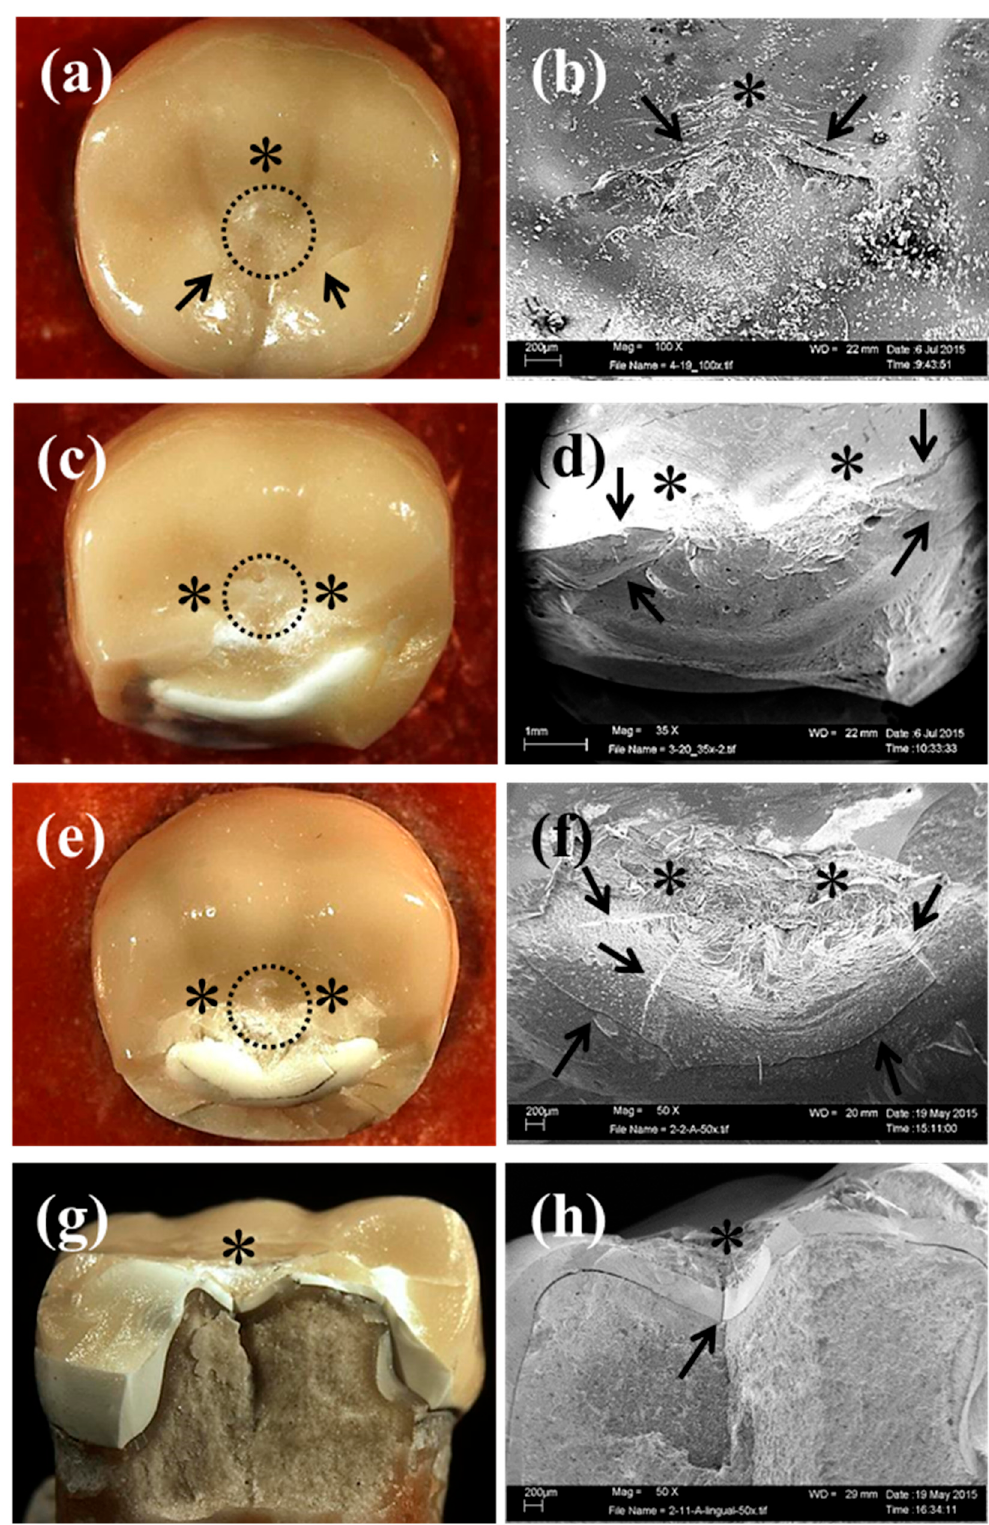
groups are shown in Table 1.